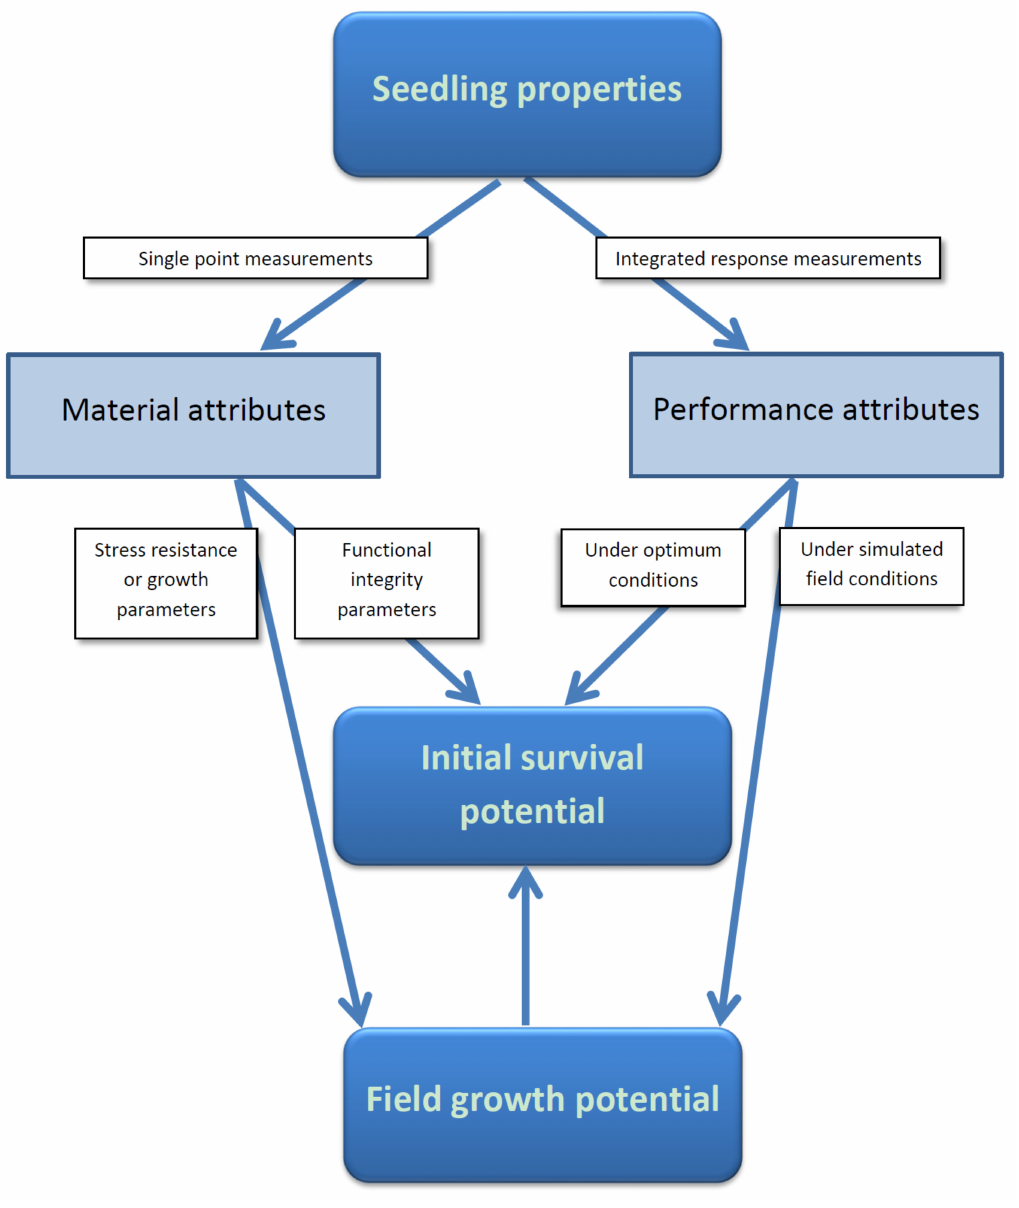
Figure 2. Conceptual model for monitoring seedling quality at the end of nursery culture (adapted from Folk and Grossnickle